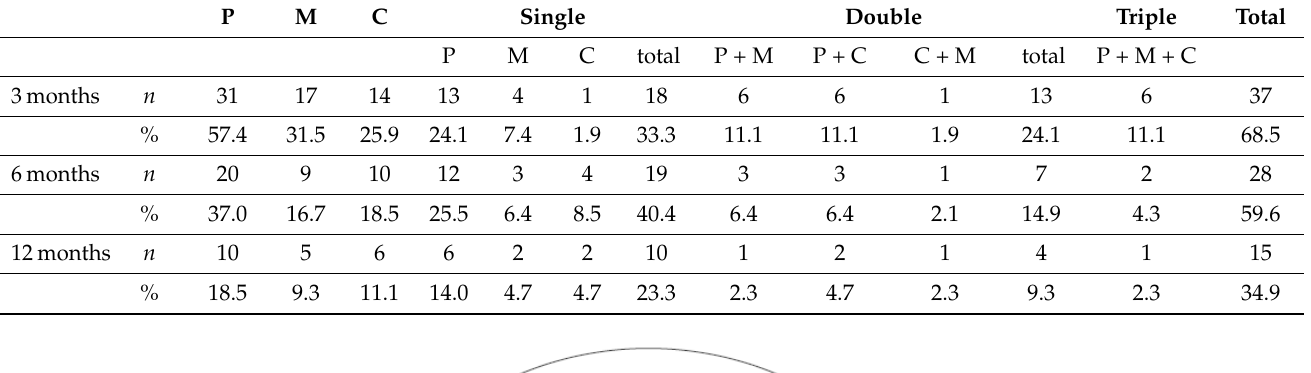
Table 3. The prevalence of each PICS domain at 3,6,12 months after ICU admission in septic patients.